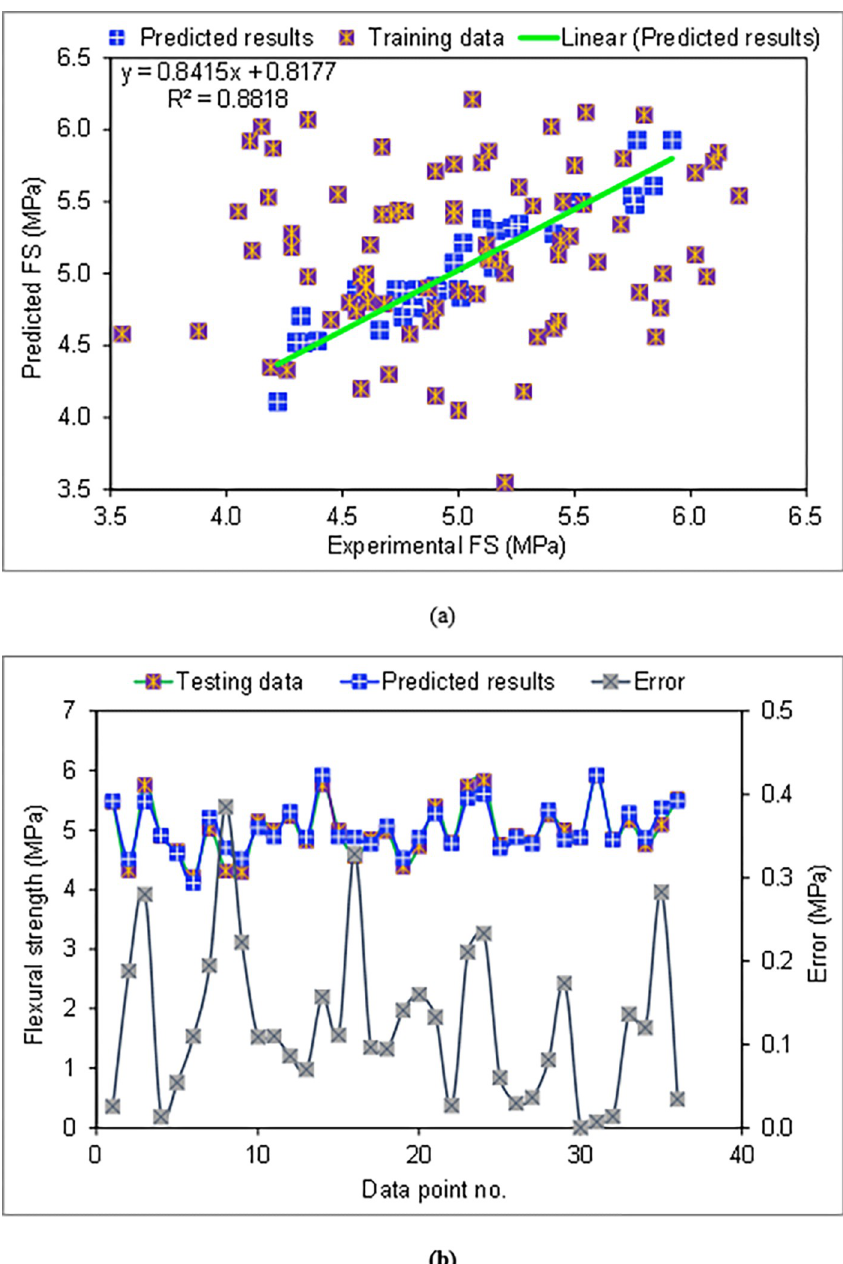
Fig 9. SVM model: (a) Correlation among actual and estimated FS; (b) Dispersion of actual, estimated and error